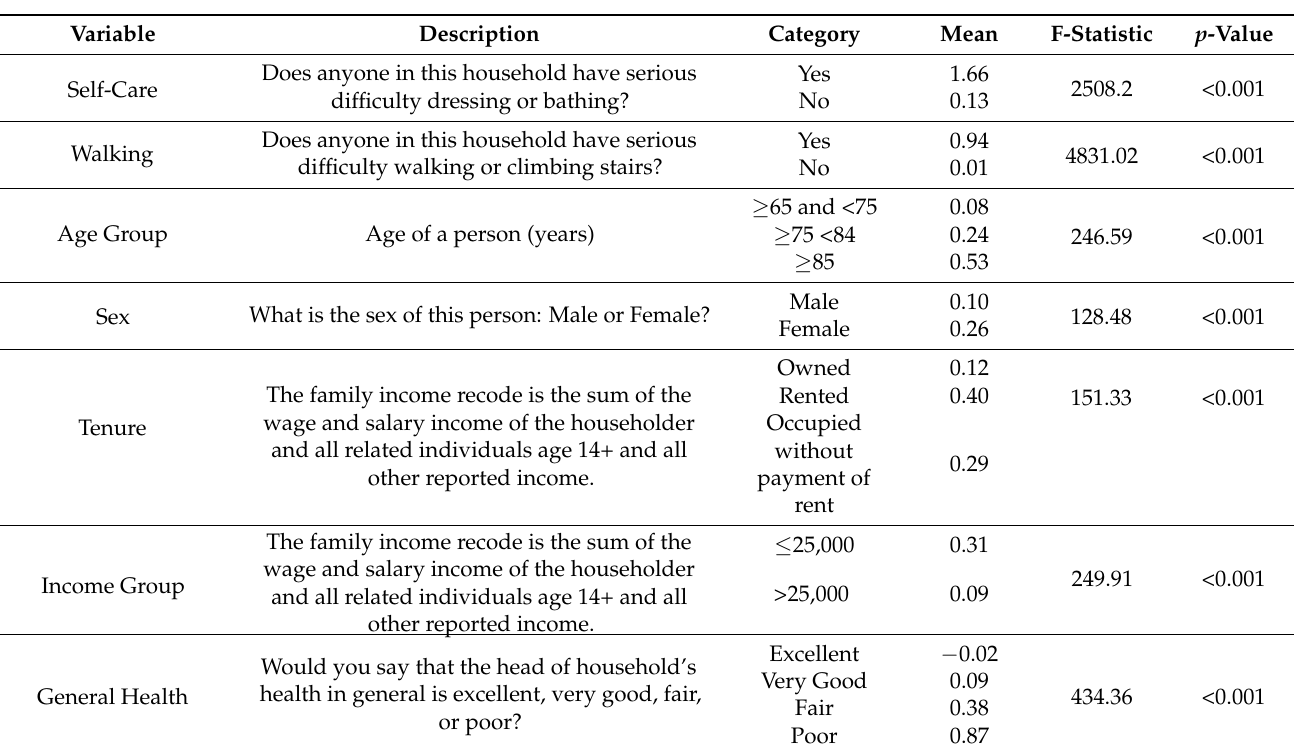
Table A1. Estimated Home Functional Difficulty Factor Scores across Demographic and